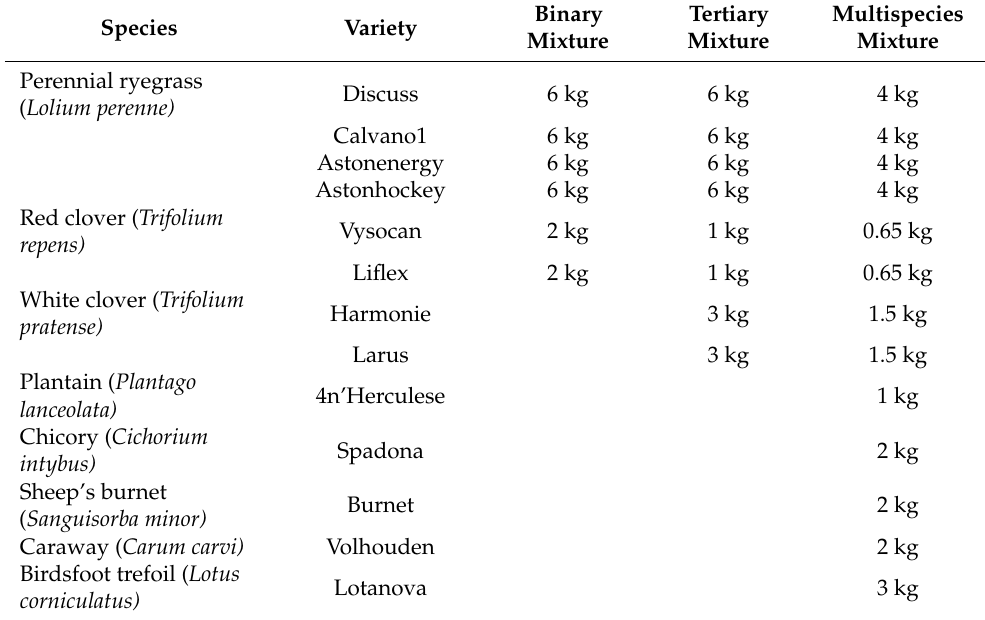
Table A1. Composition and sowing rate (kg ha − 1 ) of the grass-clover mixtures.